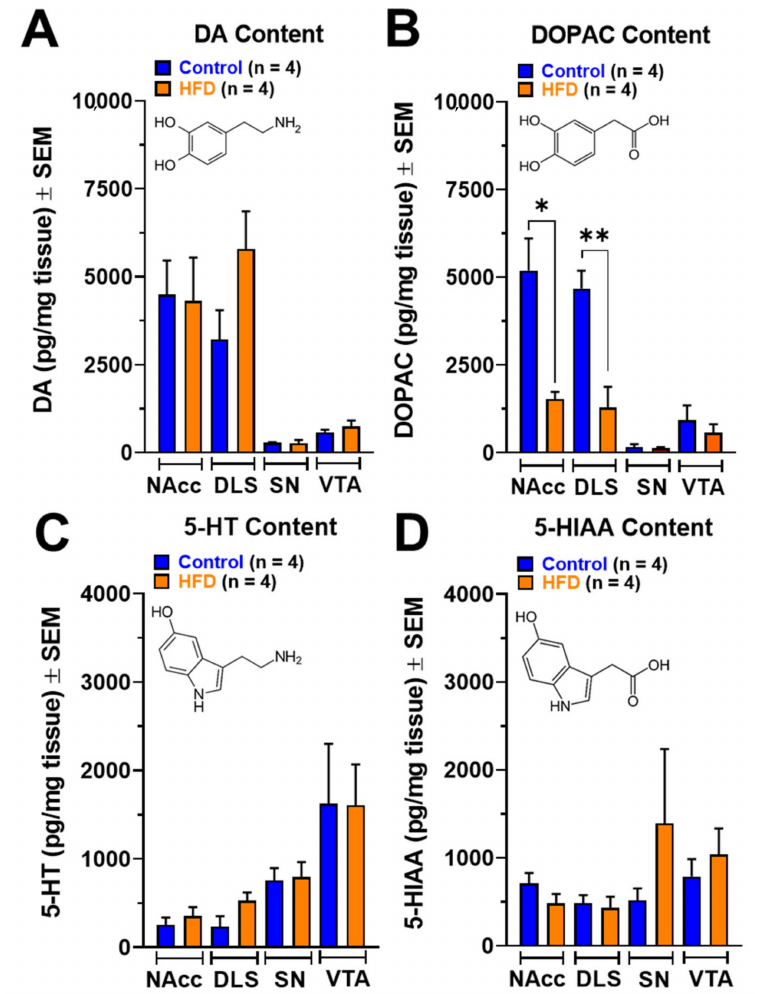
Figure 4. DA ( A ), DOPAC ( B ), 5-HT ( C ), and 5-HIAA ( D ) contents in brain nuclei of the mesolimbic (NAcc and VTA) and nigrostriatal (DLS and SN) pathways of rats exposed to HFD for six weeks. Results are expressed as pg per mg of tissue and were analyzed by unpaired t -test (* p < 0.05; ** p <